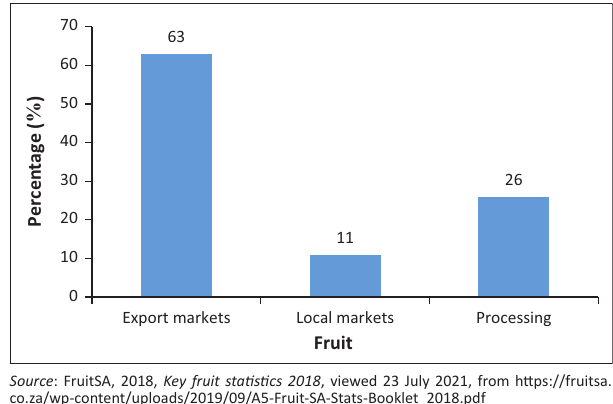
FIGURE 1: Market segmentation of the South African fruit